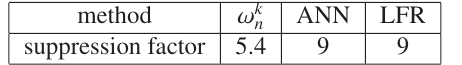
Table 1. Background suppression factor corresponding to 11% of electron / positron